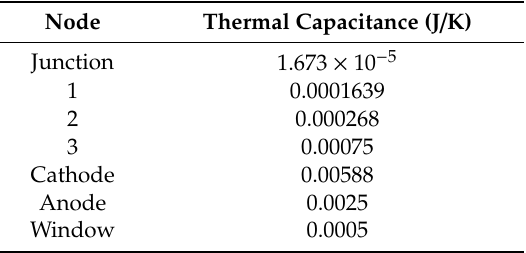
Table 3. CTM thermal capacitance